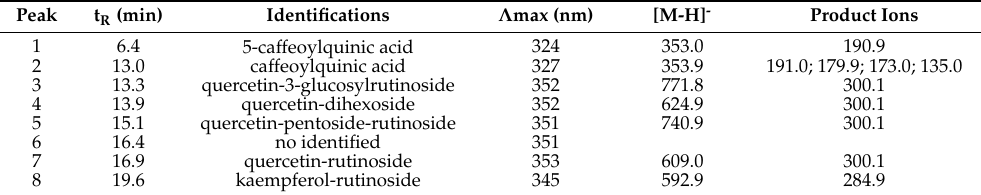
the use of ReflectXtra fungicide (Figure